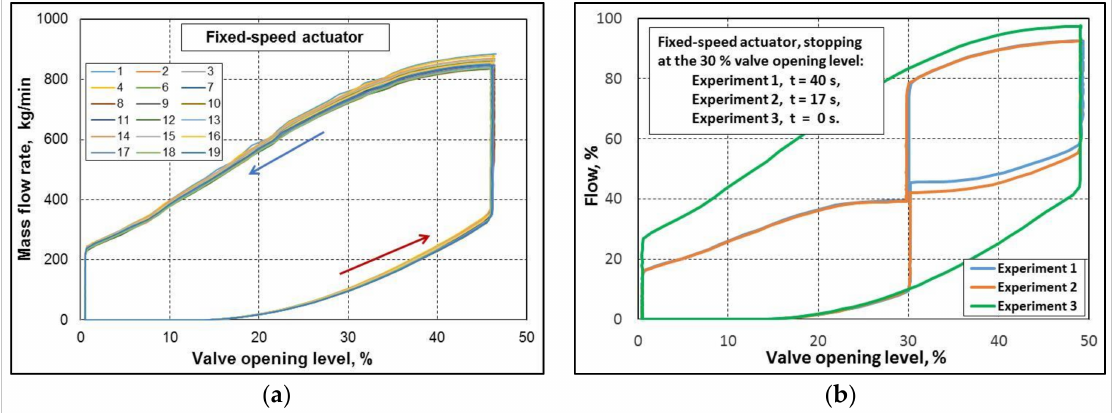
Figure 2. Mass flow vs. valve opening level: ( a ) results of 19 experiments; ( b ) experiments with stopping of